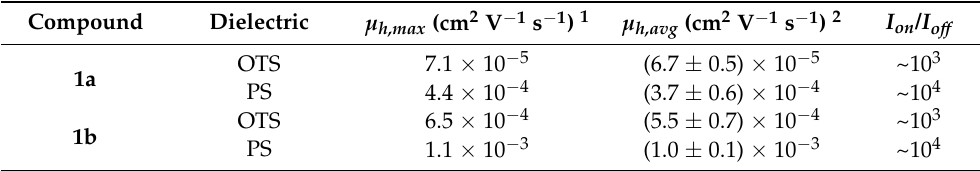
Table 3. Organic thin-film transistor (OTFT) characteristics of devices fabricated with compounds 1a – b in octadecyltrichlorosilane (OTS)- and polystyrene (PS)-treated substrates.